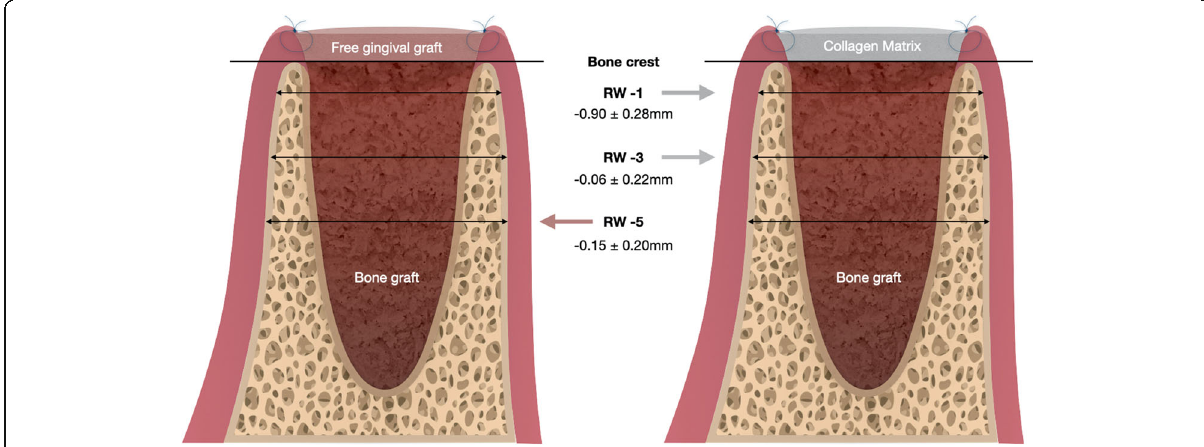
Fig. 5 Meta-analytic illustration shows a trend for slight dimensional changes on the ridge width (RW) in the collagen matrix group at − 1 and − 3 mm cutoffs and a slight RW gain of 0.15 mm favoring free gingival graft sealing